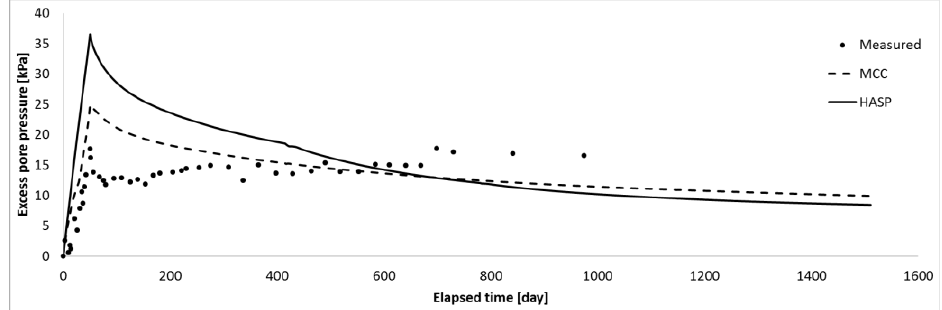
Figure 11. Comparison of excess pore pressure-time curves for Embankment A—Point P 1 (1.4 m below the surface).